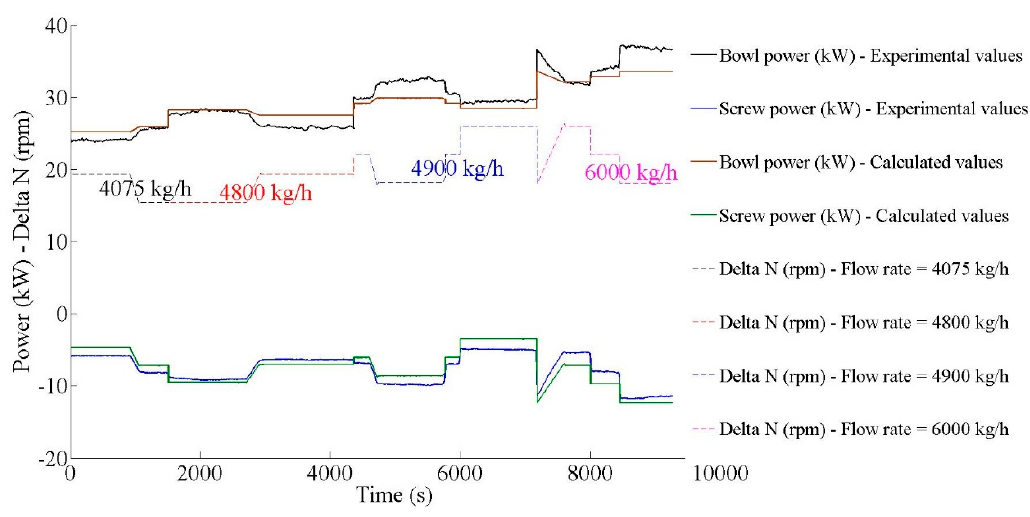
Table 4. Sets of calculated unknowns calculated using all the data available from both harvesting seasons (“all-fit” case).